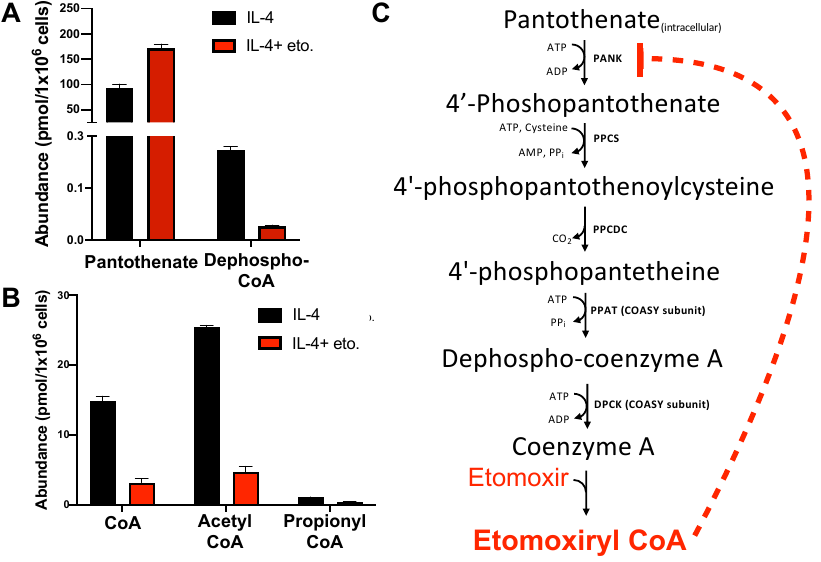
Figure 7. The SSA sample preparation and LC-MS/MS method detects changes in CoA synthesis pathway intermediates and short-chain acyl CoA species in IL-4-polarized macrophages following etomoxir treatment. Data are presented as mean ± standard error of the mean (S.E.M.) for n = 3 technical